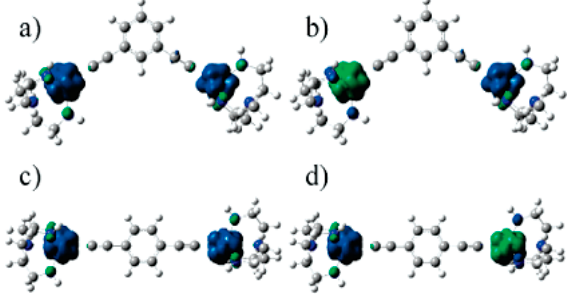
Figure 10. Net spin density plots for HS/BS meta ( a,b ) and para ( c,d ) DEB-bridged dinuclear species. (Reprinted with permission from [107], American Chemical Society, 2010).